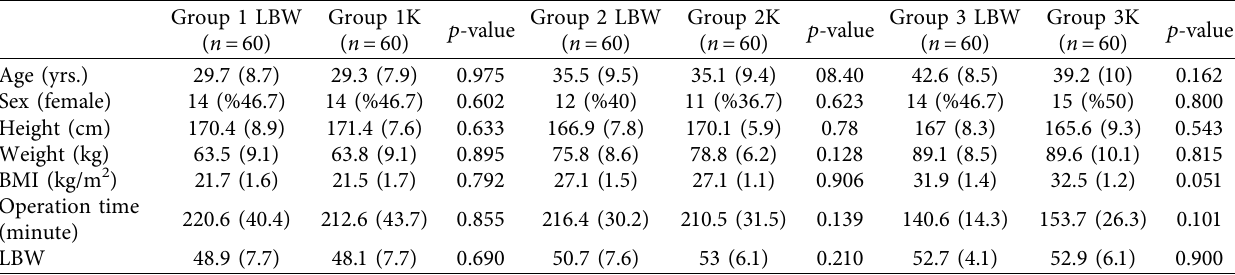
Table 2: Patient data table.